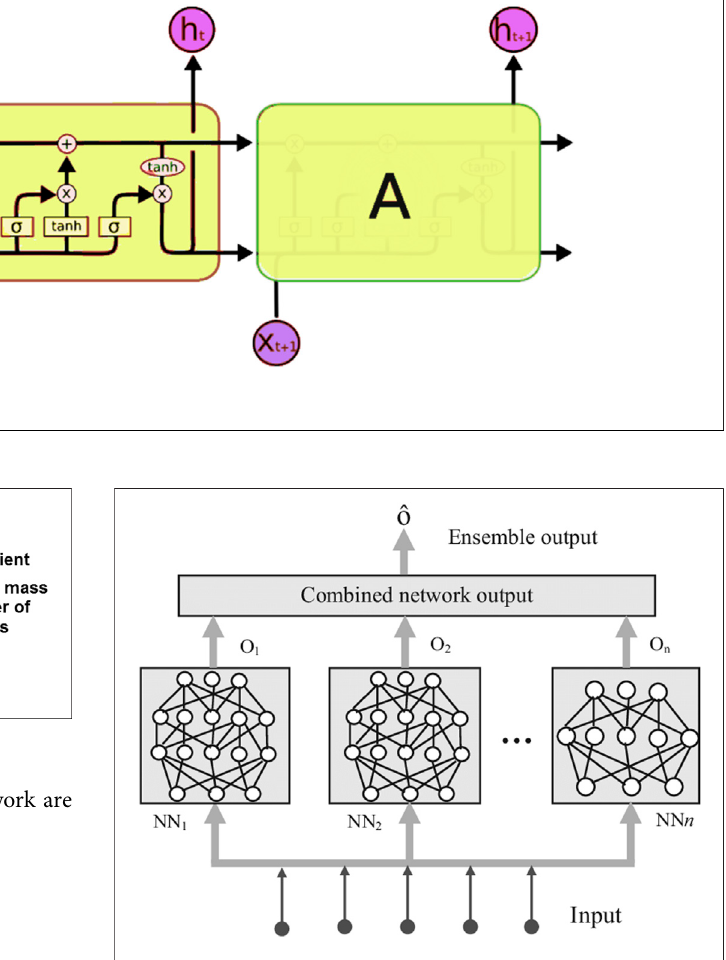
FIGURE 3 | Ensemble of neural networks (Alam et al.,